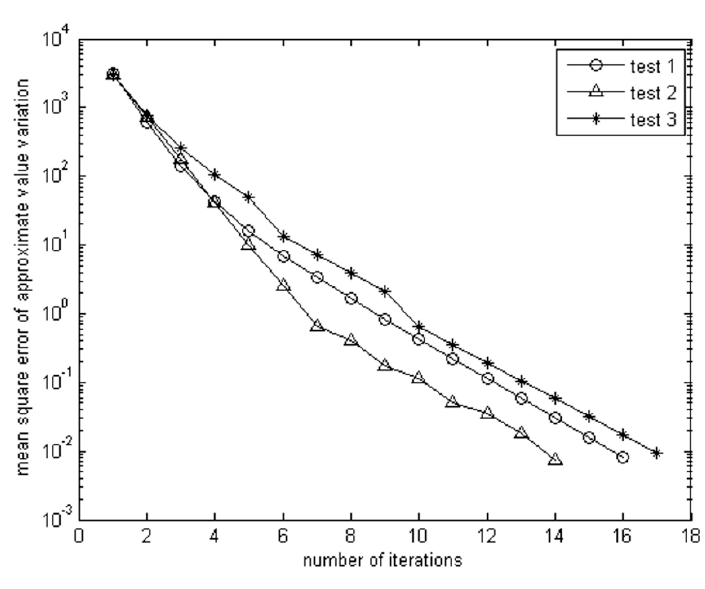
Figure 7. Example of